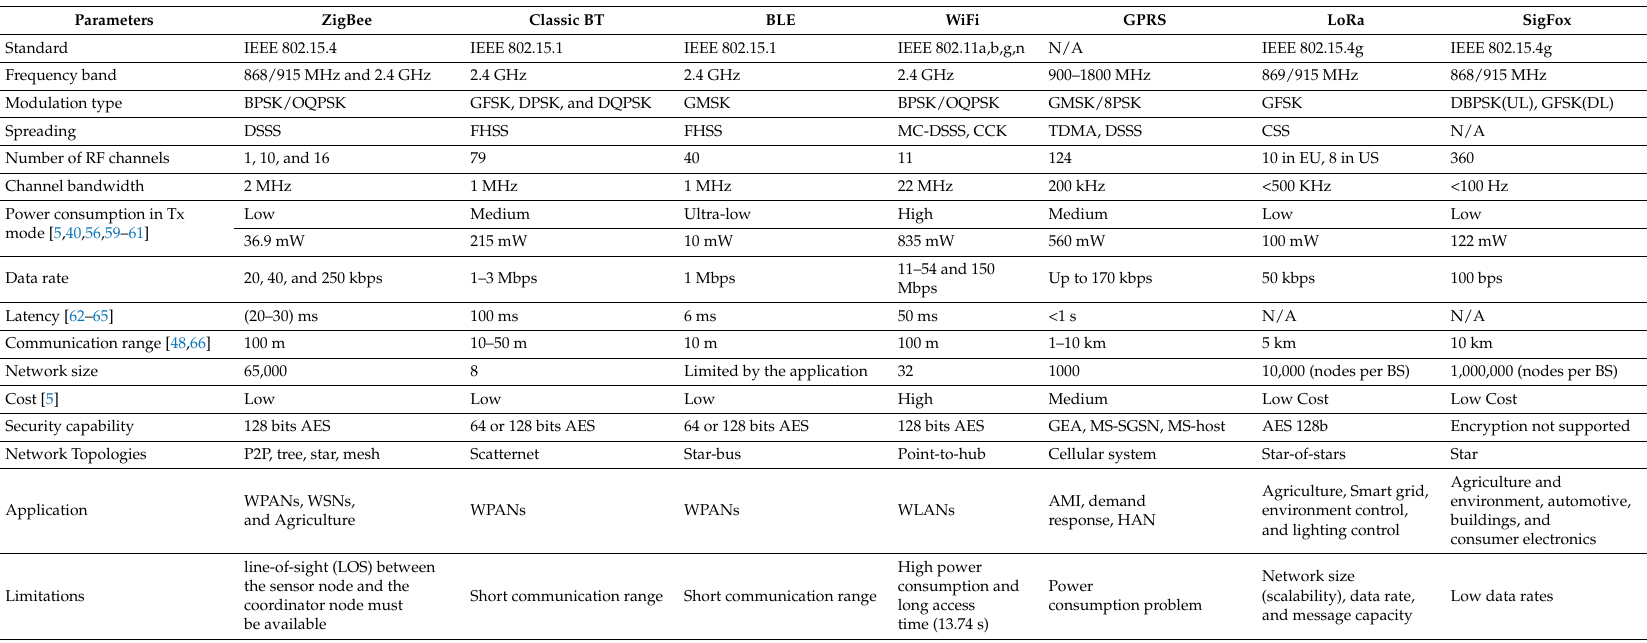
Table 1. Different wireless communication